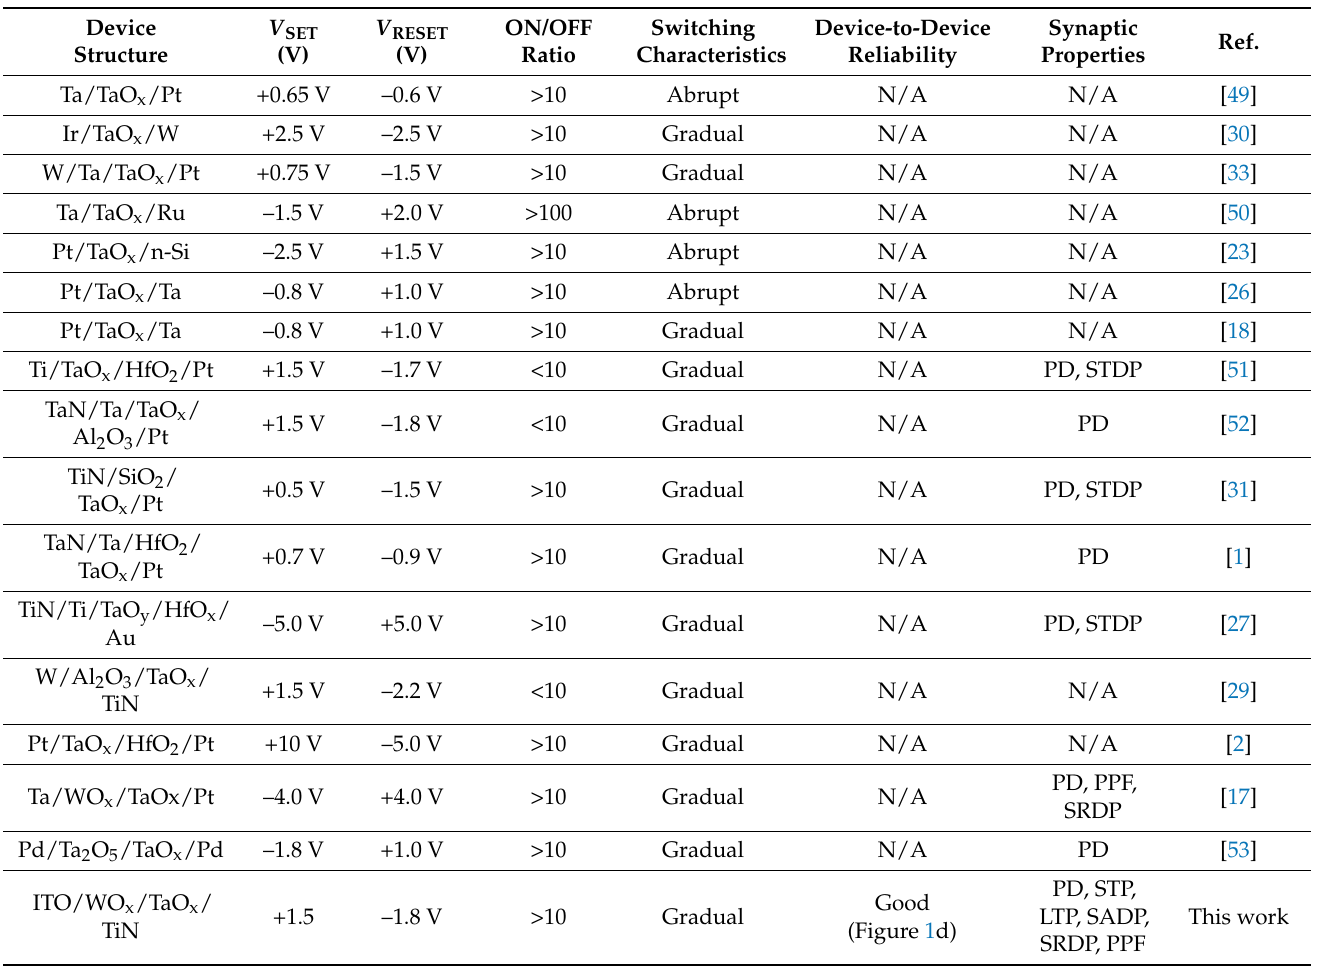
Table 1. Comparison of resistive switching and synaptic properties of the TaO x and TaO x -bilayer- based